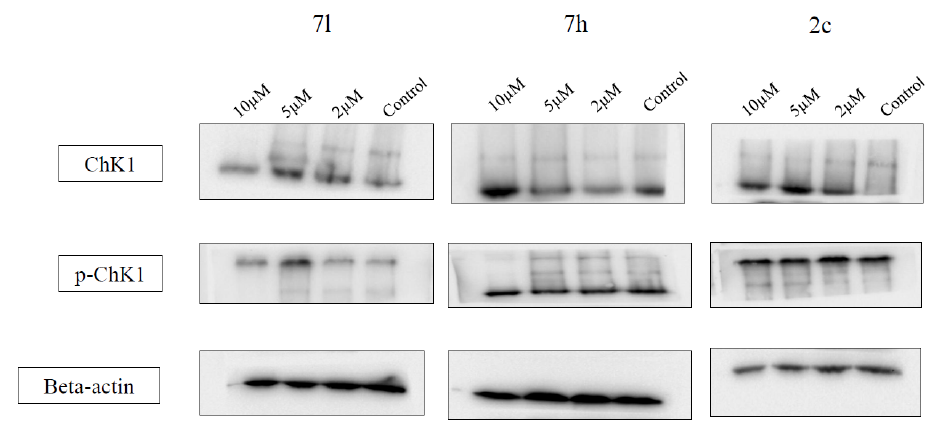
Figure 8. Expression of Chk1 and pChk1 at Ser 317 in cells analyzed by immunoblot assay with respect to treatment against compounds 7l , 7h and 2c.